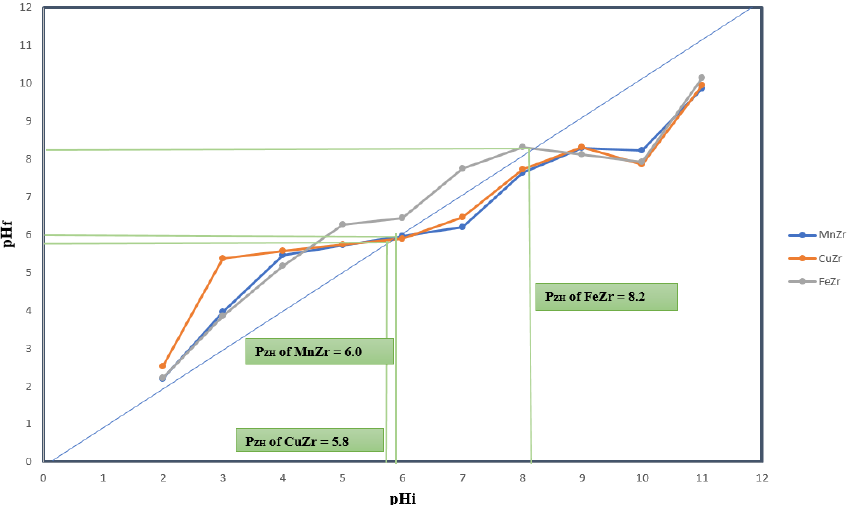
Figure 5. The measured P ZH of MnZr, CuZr, and FeZr .